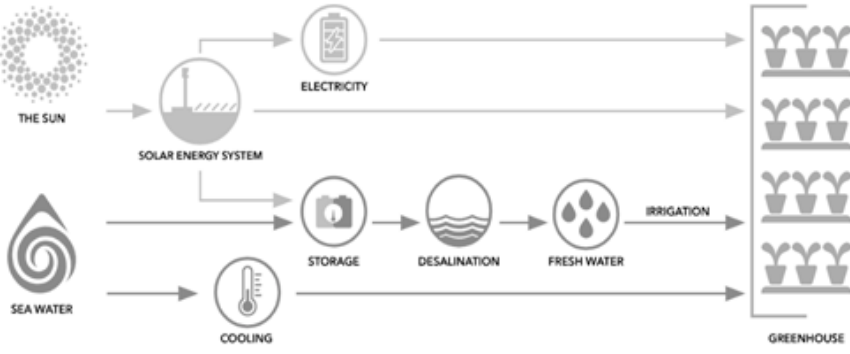
Figure 15. Desalination powered by solar PV for